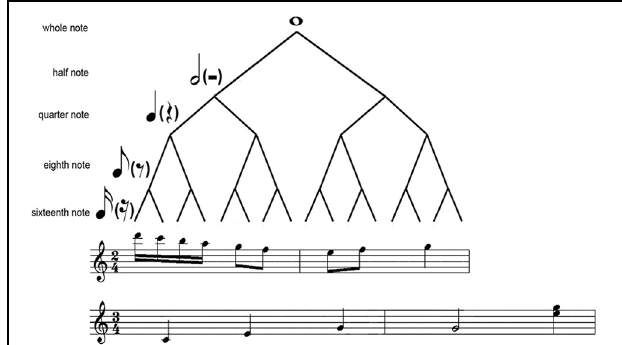
FIGURE 1 | Illustration of the hierarchical structure. Shown is a metrical tree (Longuet-Higgins and Lee, 1984; Fitch and Rosenfeld, 2007) with 2 two-measure musical samples (from “Rondo Alla Turca” and “Blue Danube”, respectively) in 4/2 or 3/4 meter.